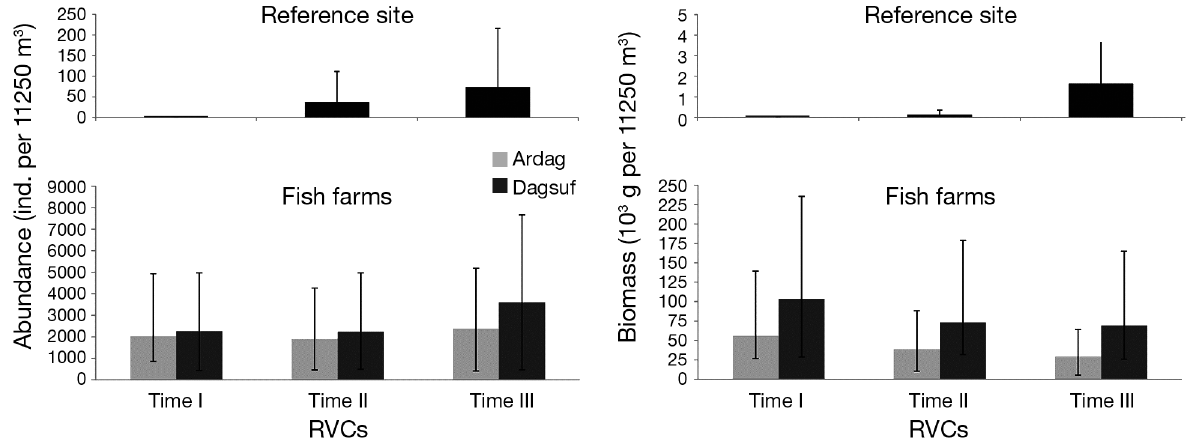
Fig. 3. Total abundance (mean ± SE) (left panel) and biomass (mean ± SE) (right panel) of coral reef-associated fish species at the reference site and fish farms on the 3 sampling dates (I = August, II = September, III = October in 2007). RVC = rapid visual